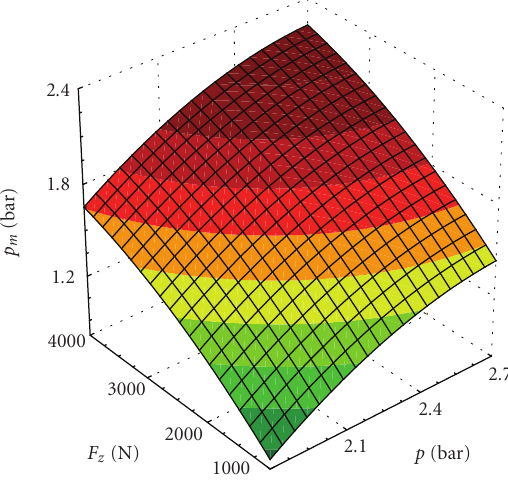
Figure 6: Nominal contact area for Tire 2 as a function of pressure and vertical load.